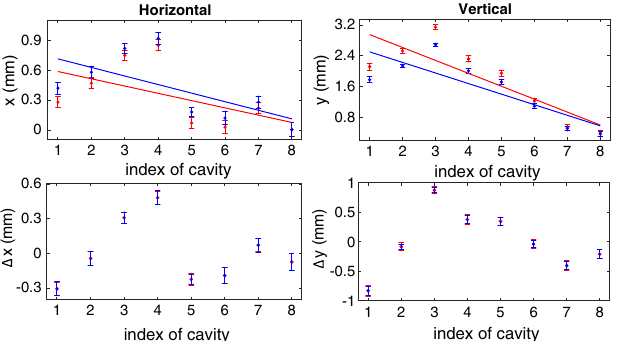
FIG. 21. HOM-based cavity misalignment for the horizontal (left) and vertical (right) planes. The results of the two individual measurements (in April 2018 and January 2019) are plotted in red and blue respectively. The upper plots show the electric centers (dots) and the module axis (lines) with respect to the reference axis defined by the BPMs. The bottom plots illustrate the residual cavity offset with respect to the calculated module